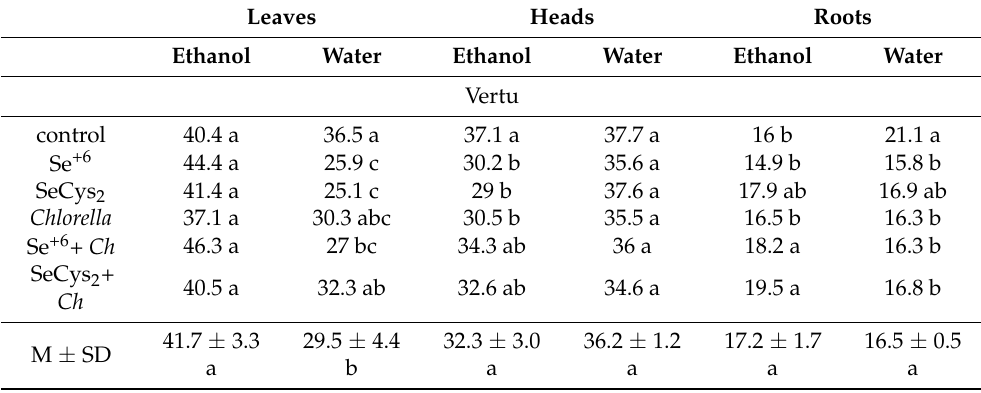
Table 4. Hydrophobic and hydrophilic extract antioxidant activity of the Savoy cabbage subjected to Se and Chlorella treatment (mg GAE g − 1